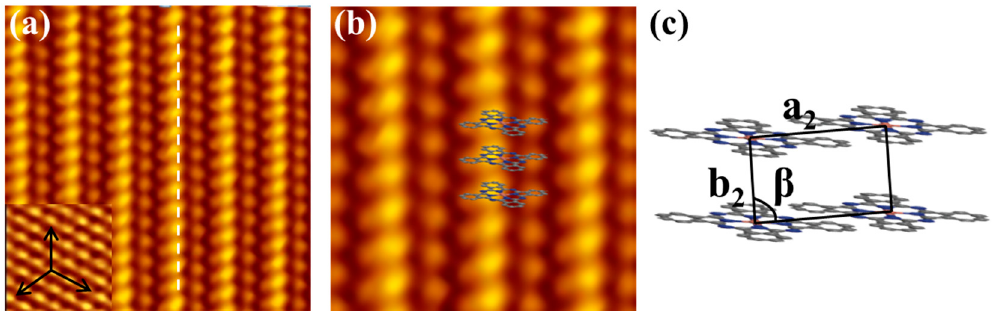
Figure 4. ( a ) High resolution STM image of the second layer of CuPc films consist of parallel standing-up CuPc chains, 7nm × 7 nm, − 0.8 V, 28 pA; ( b ) Zoomed-in STM image of the second layer domain, in which the CuPc molecules are marked by the superposed structural models; ( c ) The structural models of the unit cell in domain ( a ).